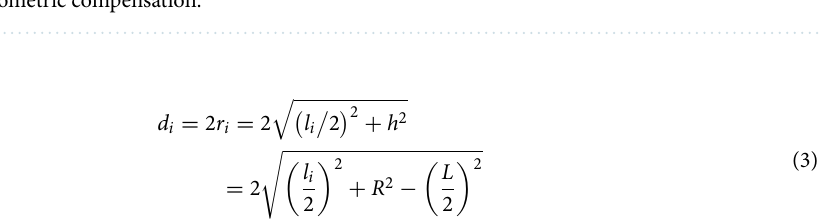
Figure 11. Interferometric